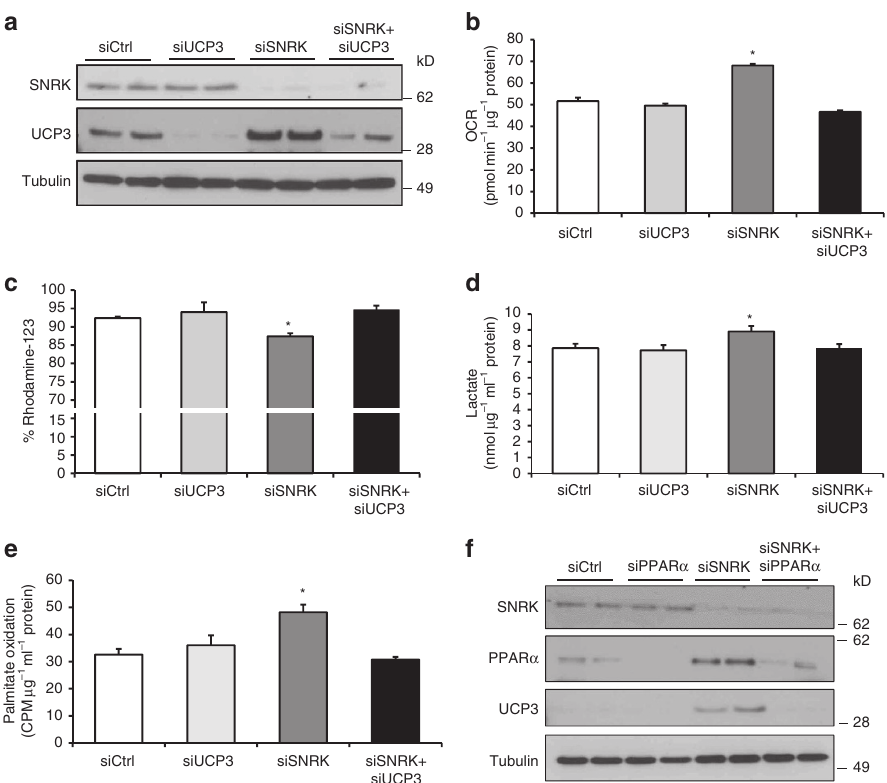
Figure 3 | SNRK decreases mitochondrial efficiency through PPAR a and UCP3. ( a ) Protein levels of SNRK, UCP3, and tubulin in HL1 cells with SNRK and UCP3 knockdown. siCtrl indicates scrambled control siRNA, siUCP3 indicates UCP3 siRNA, siSNRK indicates SNRK siRNA, and siSNRK þ siUCP3 indicates treatment with both siRNAs. Oxygen consumption rate (OCR, b , n ¼ 6), mitochondrial membrane potential ( c , n ¼ 3), lactate levels ( d , n ¼ 6), and palmitate oxidation ( e , n ¼ 3) in HL1 cells with SNRK and/or UCP3 knockdown. ( f ) Protein levels of SNRK, PPAR a , UCP3, and tubulin in HL1 cells with SNRK and/or PPAR a knockdown. Labels above blots indicate siRNAs used. Experiment is representative of three independent samples. Data are represented as mean ± s.e.m. * P r 0.05 by one-way ANOVA. ANOVA, analysis of